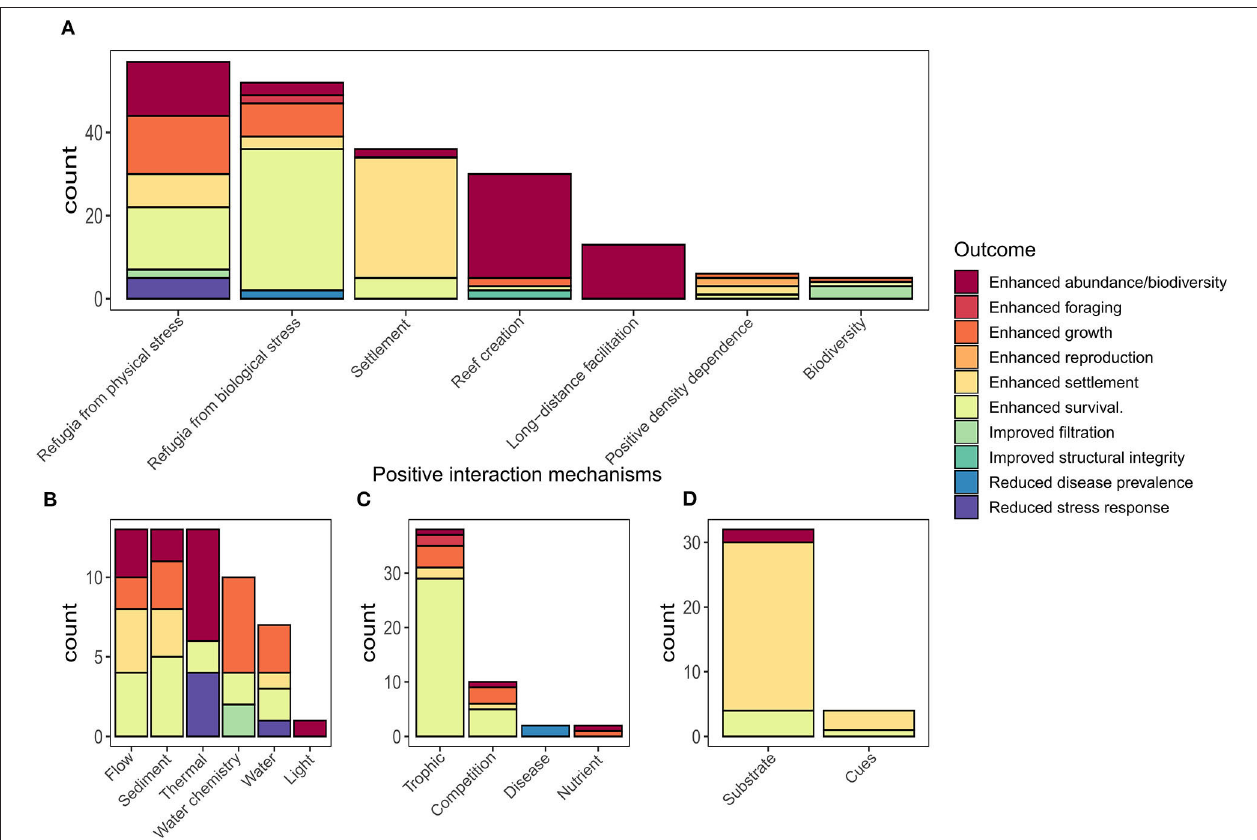
FIGURE 6 | Outcomes of positive species interactions summarized by interaction mechanisms: (A) overview of positive interaction mechanisms by category, (B–D) display sub-categories for (B) refugia from physical stress; (C) refugia from biological stress; and (D) settlement categories individually summarized for sub-categories of positive species interactions. Note y-axis scales differ between